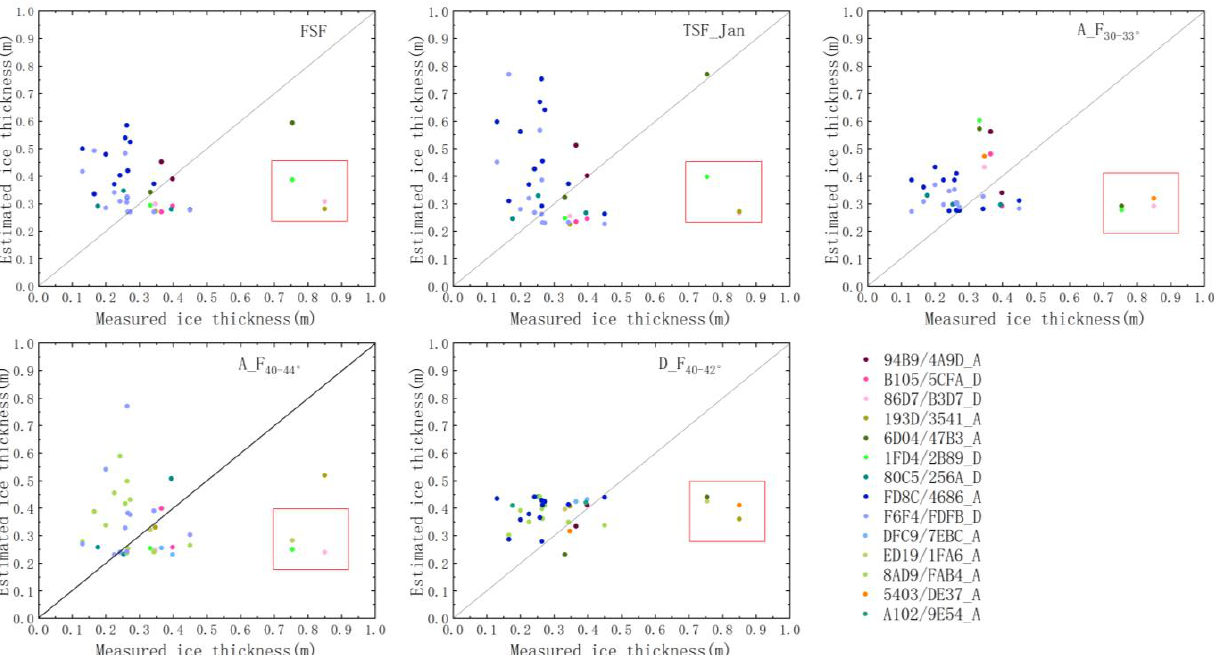
Figure 9. Analysis of the applicability of the Babao River schemes. In the figure legend, for example, in 94B9/4A9D_A, 4A9D indicates the image name, where A indicates an ascending orbit (refer to Figure 3). Figure